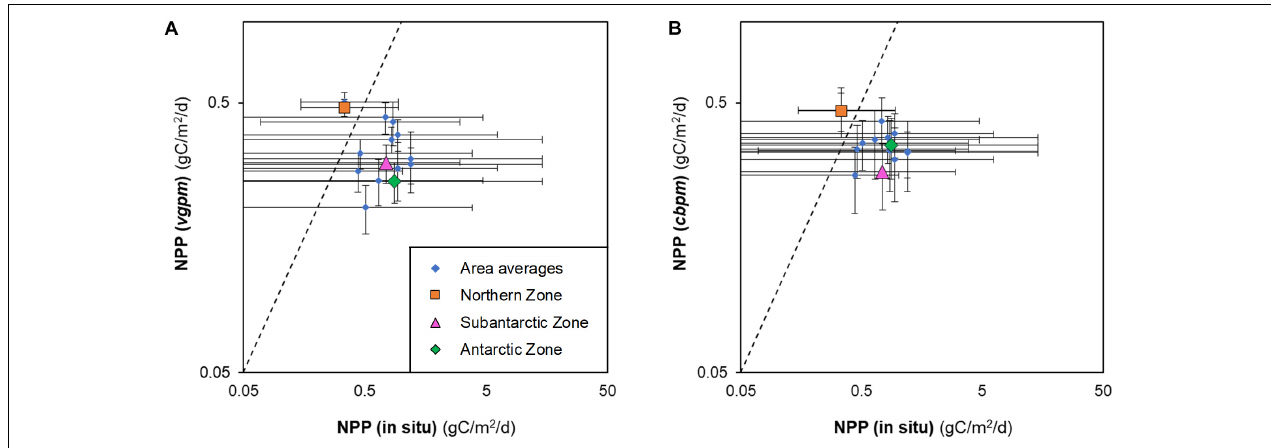
FIGURE 1 | Depth-integrated, net primary productivity (NPP) in the Southern Ocean measured in situ from research vessels and estimated from satellite data: (A) Vertically Generalised Production Model ( vgpm ); and (B) Carbon Based Production Model ( cbpm ). Data are combined as MEASO areas (blue) and zones (orange, pink, green). Dashed lines indicate 1:1